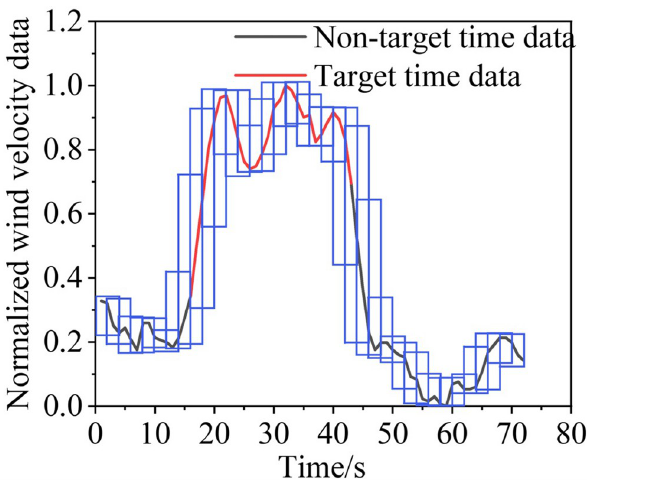
Fig 15. Sliding window discretized with 0 scalings.